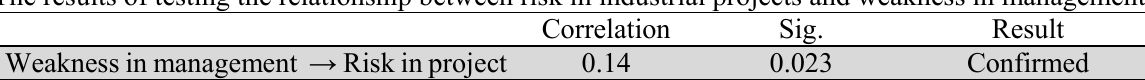
The results of testing the relationship between risk in industrial projects and weakness in management Correlation Sig. Result Weakness in management → Risk in project 0.14 0.023 Confirmed